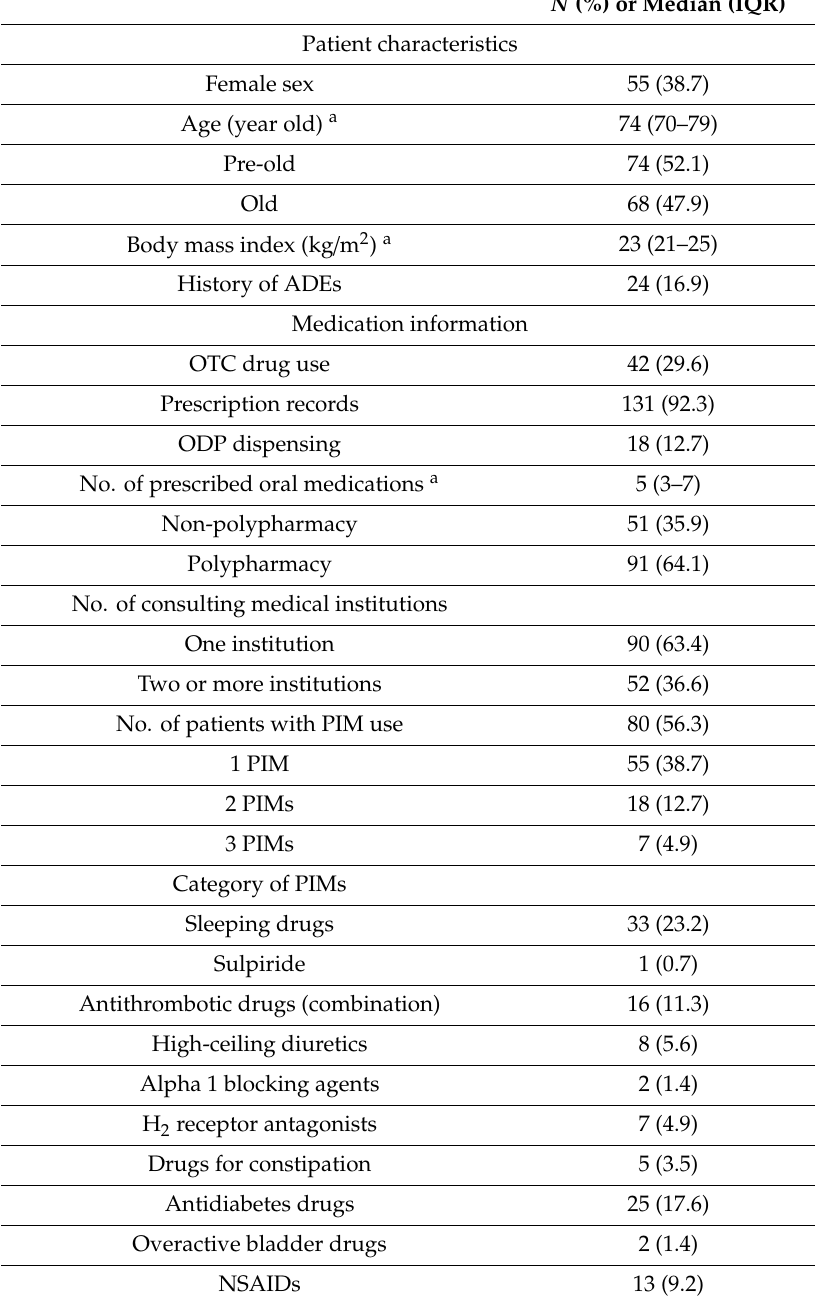
Table 1. Patient characteristics and medication information ( n =